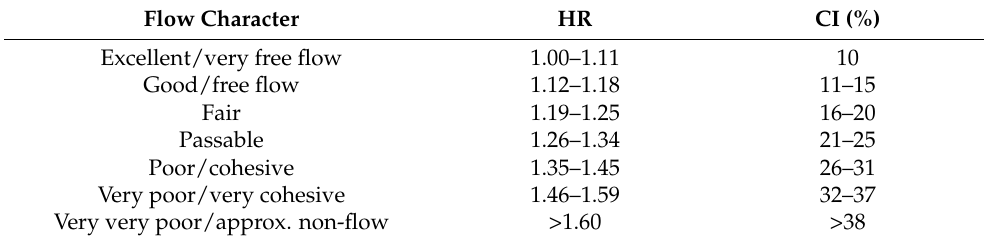
Table 2. The relationship between Compressibility index, Hausner ratio, and flowability. Flow Character HR CI (%) Excellent/very free flow 1.00–1.11 Good/free